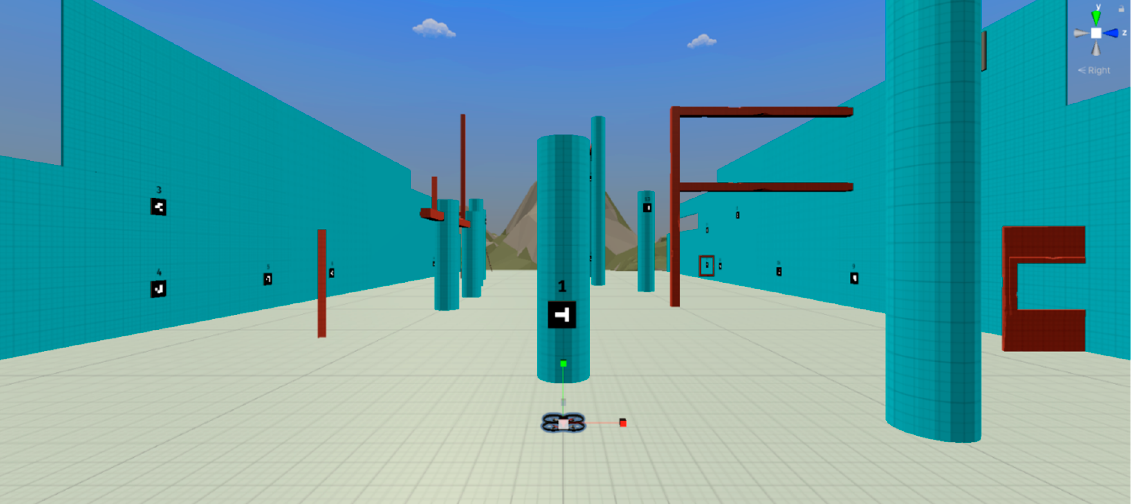
Figure 16. Virtual environment simulated in Unity for Test 3, with the trajectory configured for the second test scenario (i.e., level 2).